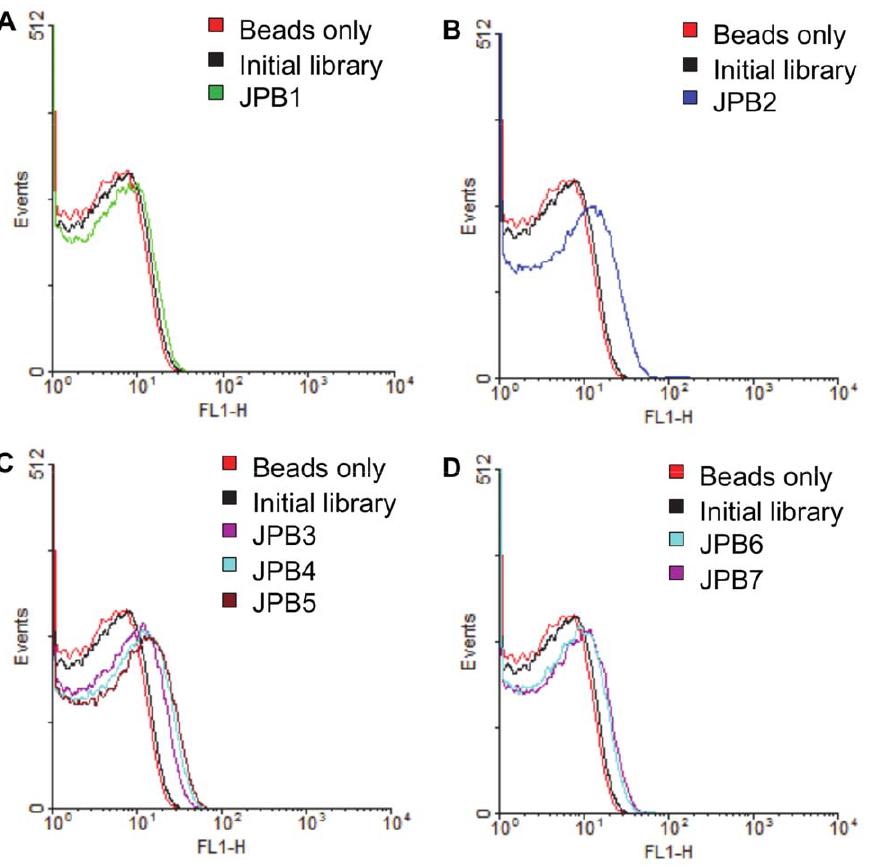
Figure 3. Flow cytometry binding studies of drug with aptamer candidates. A) JPB1; B) JPB2; C) JPB3–5; D) JPB6–7.